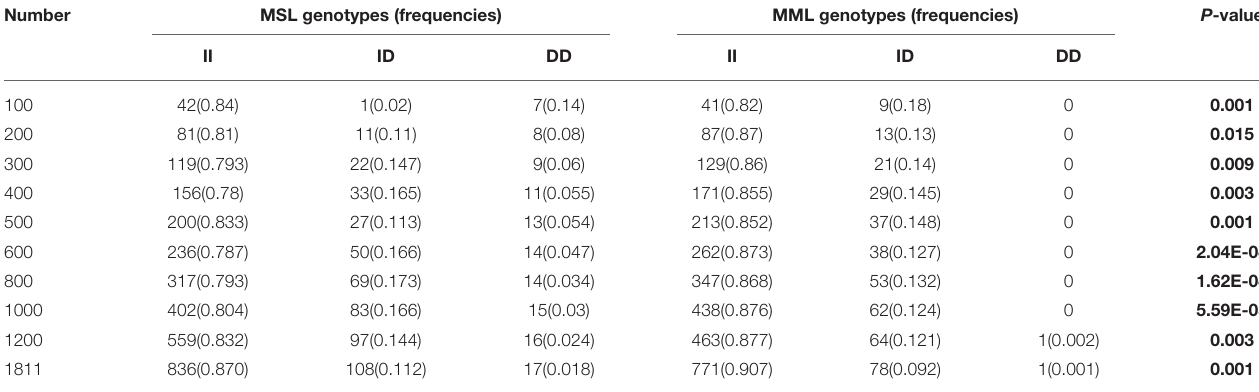
TABLE 5 | The 16 bp locus genotype distribution between mothers of single lamb and multi-lamb litters in Shaanbei white cashmere goats.